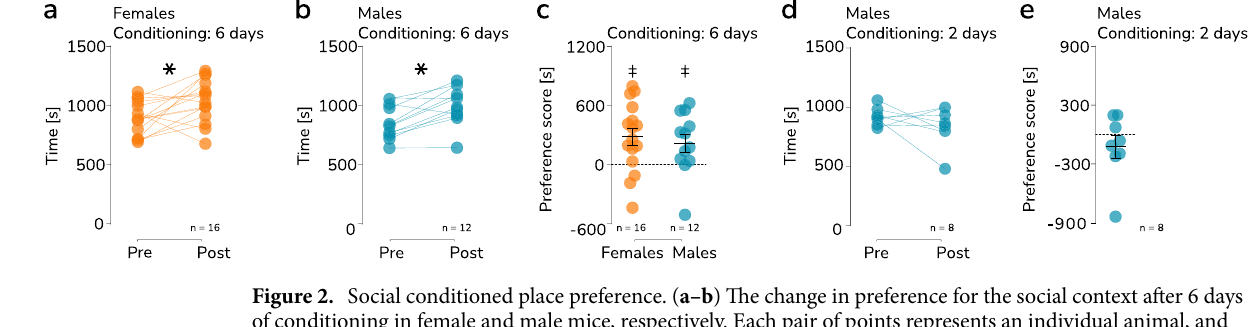
Figure 2. Social conditioned place preference. ( a–b ) The change in preference for the social context after 6 days of conditioning in female and male mice, respectively. Each pair of points represents an individual animal, and the group sizes are indicated below the graphs. A significant difference between the pre- and posttests (30 min) is marked with a “*” (paired t-test, p < 0.05). ( c ) No difference between females and males preference score [s], calculated as time spent in social context posttest [s] minus time spent in in isolate context posttest [s]. Each point represents an individual female or male mouse, with the mean and s.e.m. shown in black and the group sizes indicated below. A significant preference (greater than 0) is indicated by a “‡” (one-sample t-test p < 0.05). ( d ) No significant change in preference for the social context after 2 days of conditioning in male mice. ( e ) The preference score for social context during the posttest after 2 days of conditioning. The group sizes are indicated below the